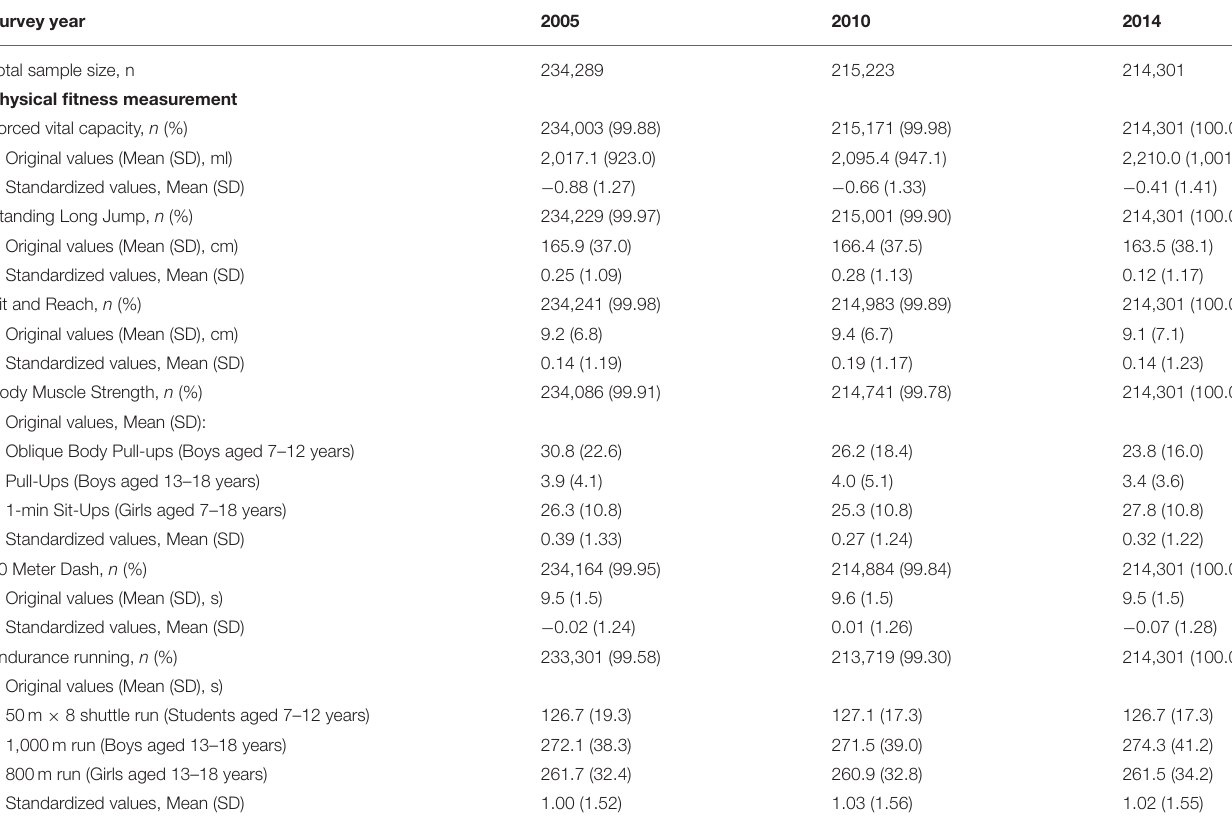
TABLE 1 | The sample size and distribution of each physical fitness component from 2005 to 2014 in